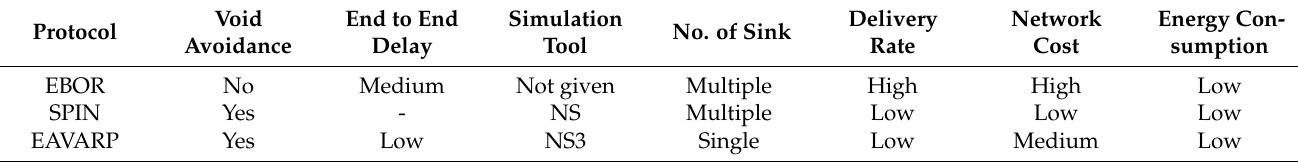
Table 17. Comparison of flooding-based routing protocol.